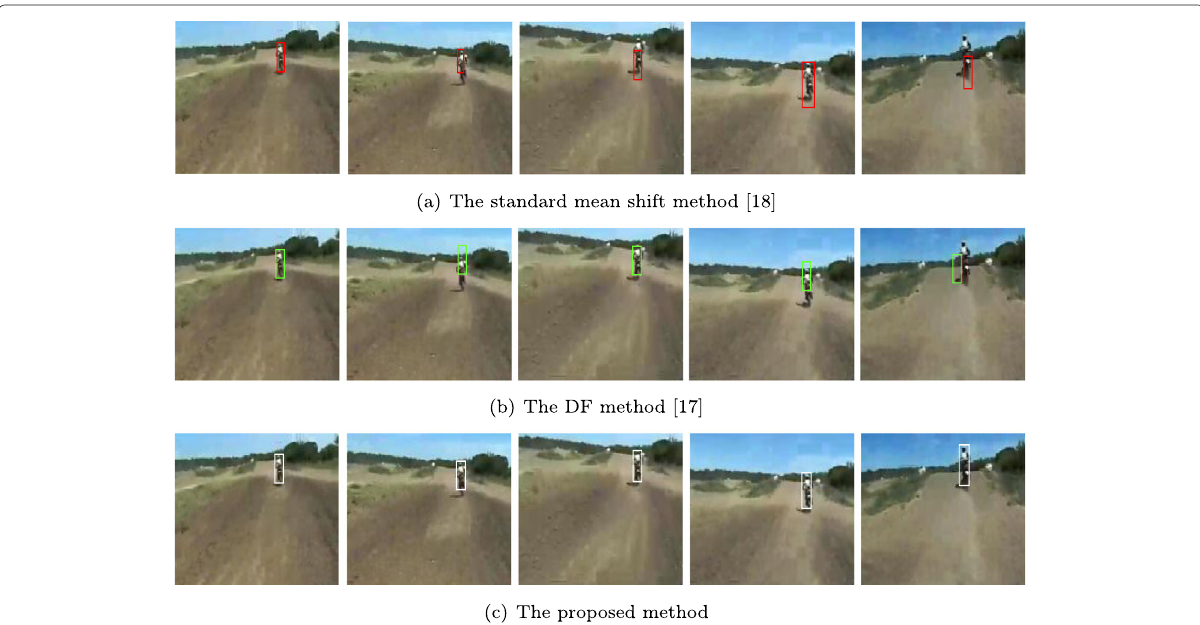
Fig. 4 Tracking results on motocross video sequence for frames of 2, 7, 10, 17, and 27. a The standard mean shift method [18]. b The DF method [17]. c The proposed